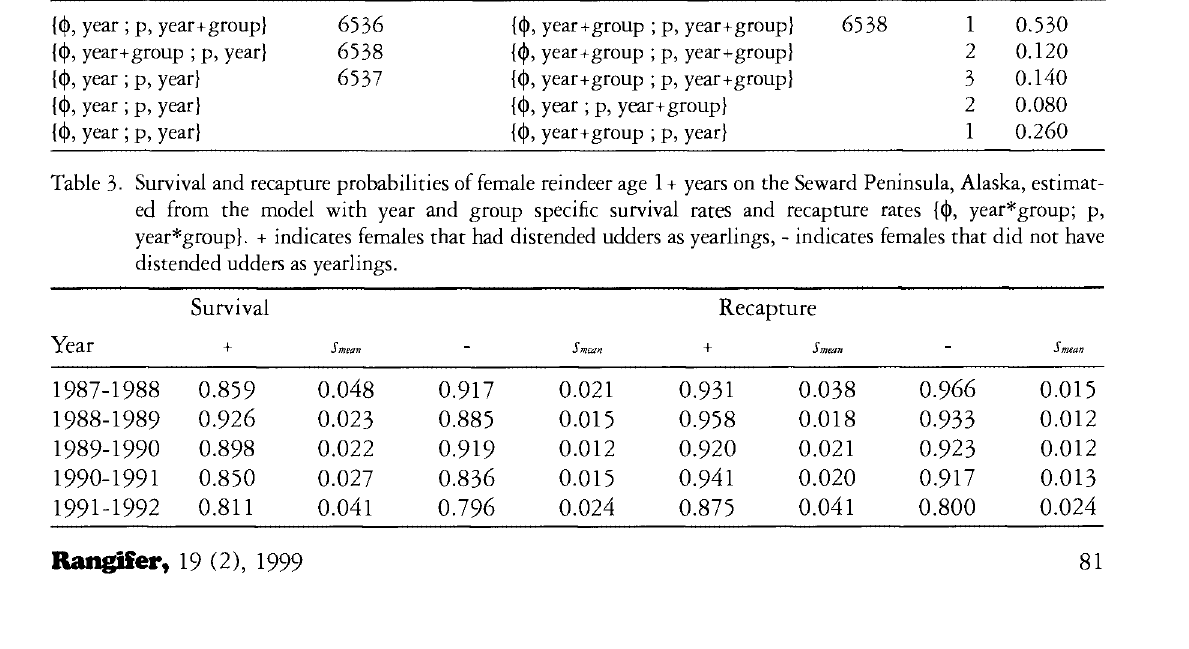
Fig. 4. Proportion of female reindeer on the Seward Peninsula, Alaska, with distended udders (±1 J ™) in June and early July as a function of age. Open bars represent female reindeer with dis tended udders as yearlings and hatched bars rep resent females that did not have distended udders as yearlings. Numbers above bars are sample sizes. due to reproductive status as yearlings (P = 0.789).